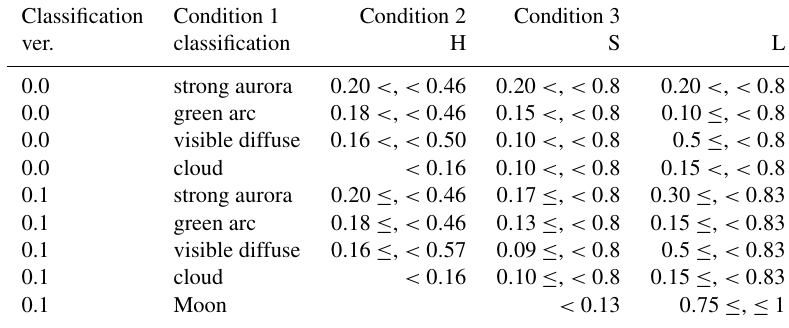
Table A1. Version 0.0 criteria of the ASC auroral index for the old ASC (Nikon